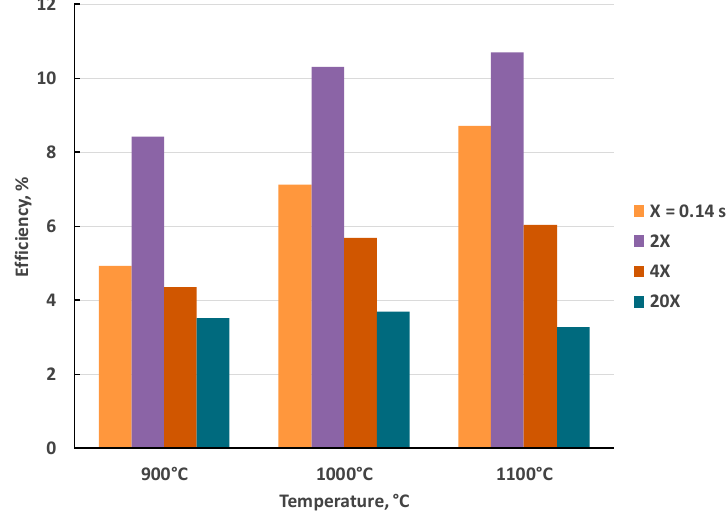
Figure 10. Effect of mean residence time (MRT) and temperature on overall thermal efficiency for conversion of thermal energy into chemical energy. Here, X corresponds to a MRT of 0.14 s. CO 2 to CH 4 feed ratio was 1:1 in all cases. For the other data sets, the number in front of the ‘X’ represents the multiples of the residence time (e.g., 20X corresponds to a residence time that is 20-fold longer). ChemEngineering 2018 , 2 , x FOR PEER REVIEW